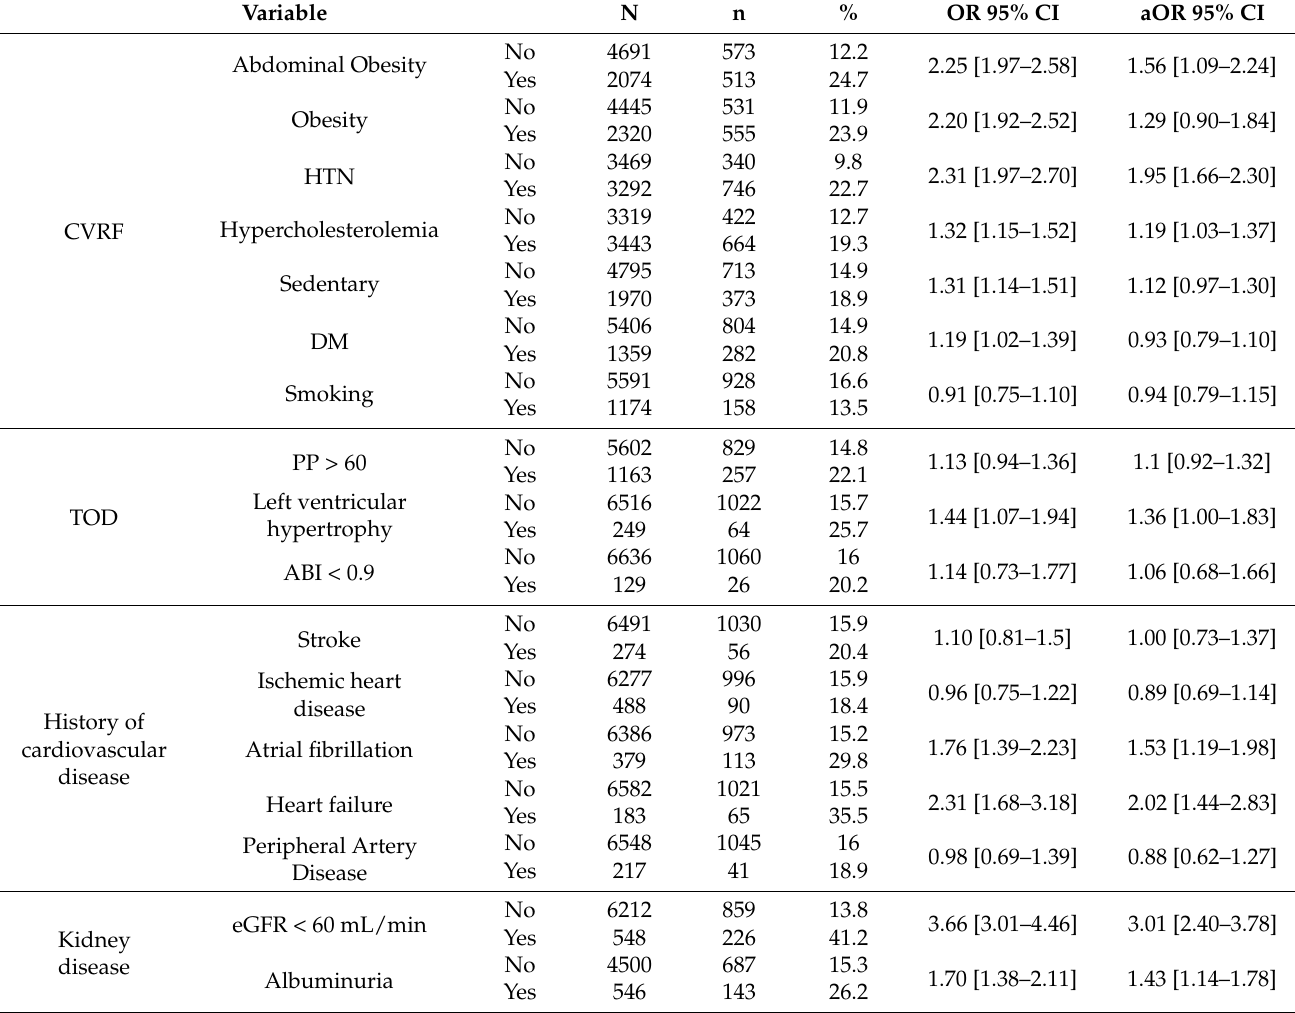
Table 2. Distribution in the prevalence of hyperuricemia according to cardiovascular risk factors, target organ damage, and history of cardiovascular